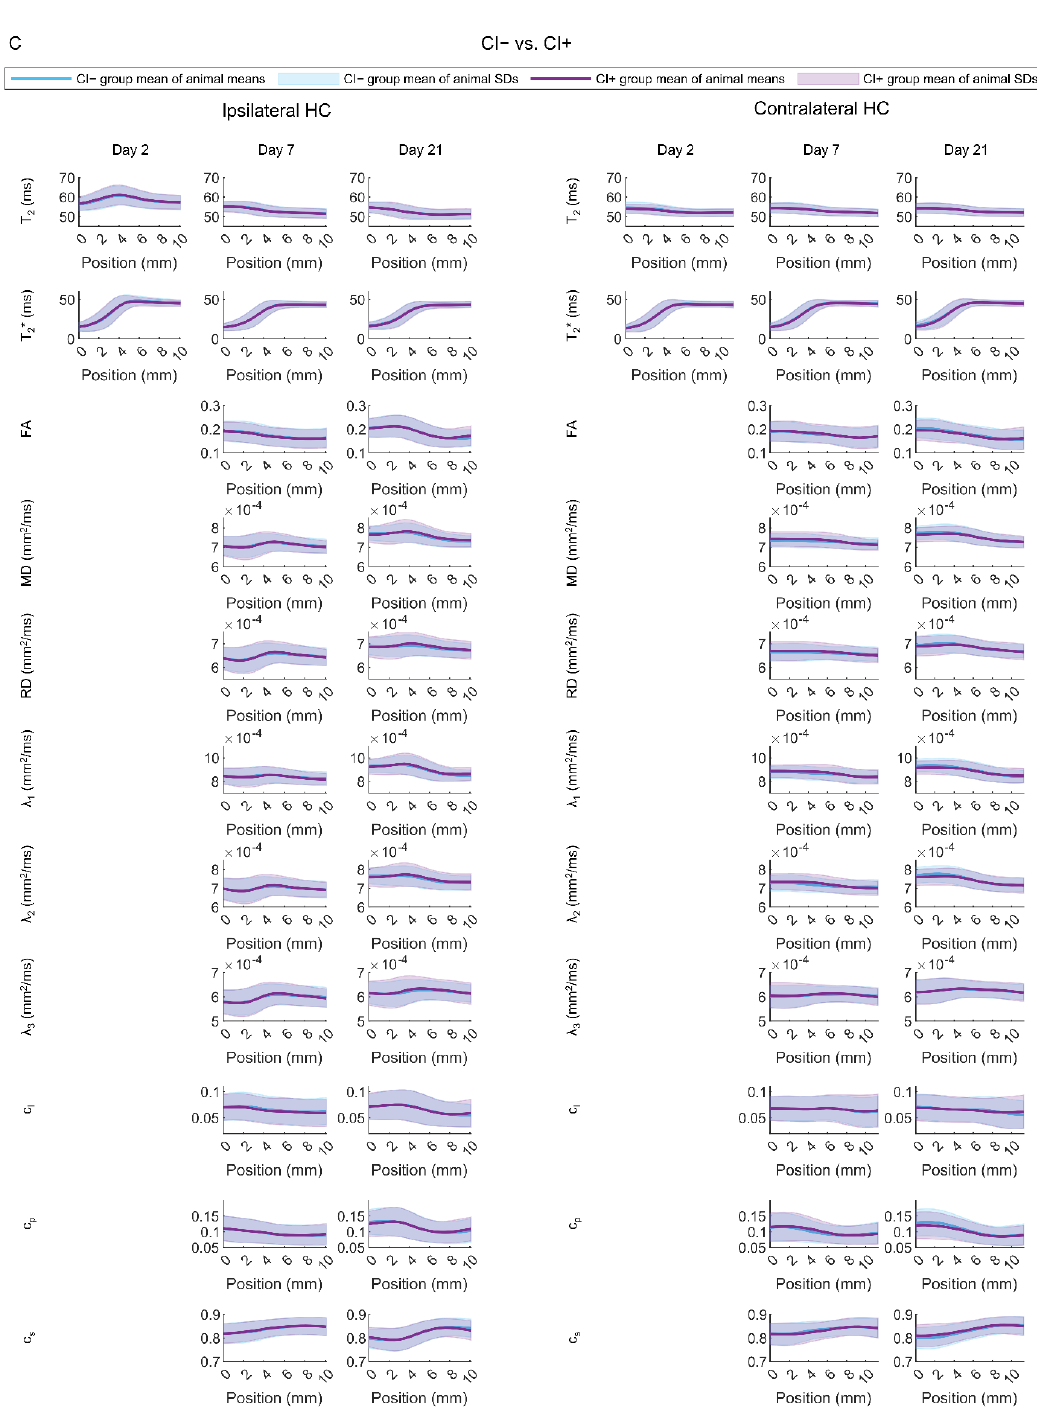
Figure 5. Hippocampal MRI parameter maps. ( A ) Comparison between rats with sham-operation or traumatic brain injury (TBI). ( B ) Comparison between injured rats without (TBI − ) or with (TBI+) epilepsy. ( C ) Comparison between injured rats without (CI − ) or with (CI+) cognitive impairment. The mean and standard deviation (SD) of each MRI parameter map were estimated at different positions along the septotemporal axis of the hippocampus for each animal (0 refers to the temporal pole). The plots show the group averages of the animal means (line) and SDs (shaded area). Abbreviations: FA, fractional anisotropy; MD, mean diffusivity; RD, radial diffusivity. Statistical significance: The Mann–Whitney U-test was used to test for differences between the groups in mean and SD of each parameter at each position along the hippocampal axis. A statistically significant difference after controlling for multiple comparisons is indicated with